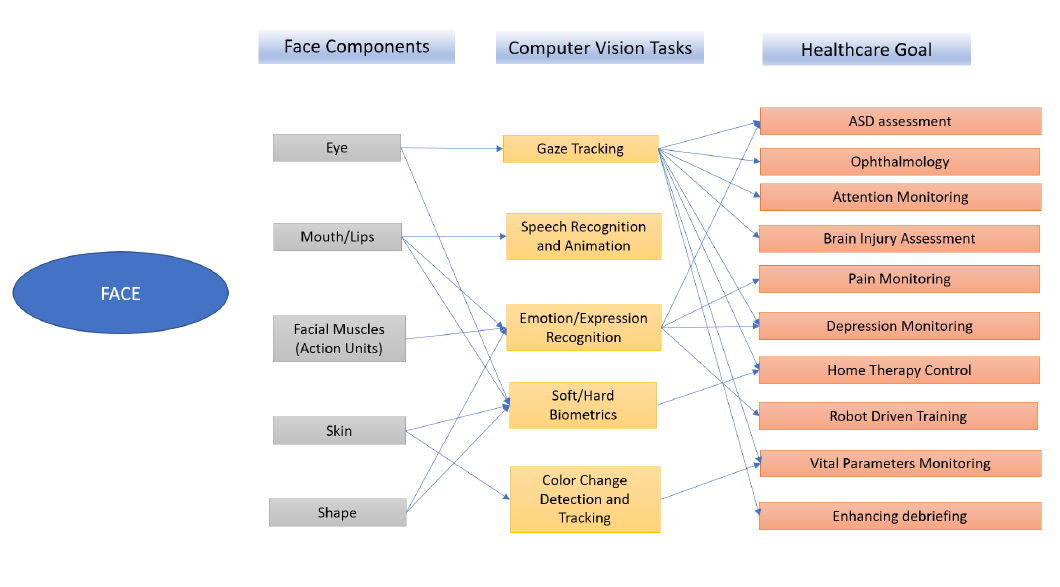
Figure 1. A scheme introducing a coarse taxonomy for face analysis in